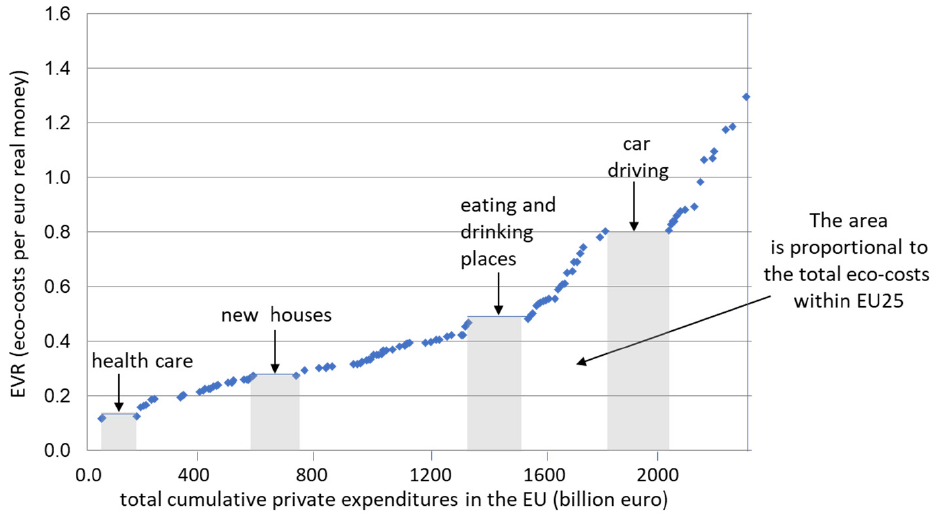
Figure 6. The EVR and the total expenditures of all consumers in the EU25 (from the environmental impact of products (EIPRO) study [38]).